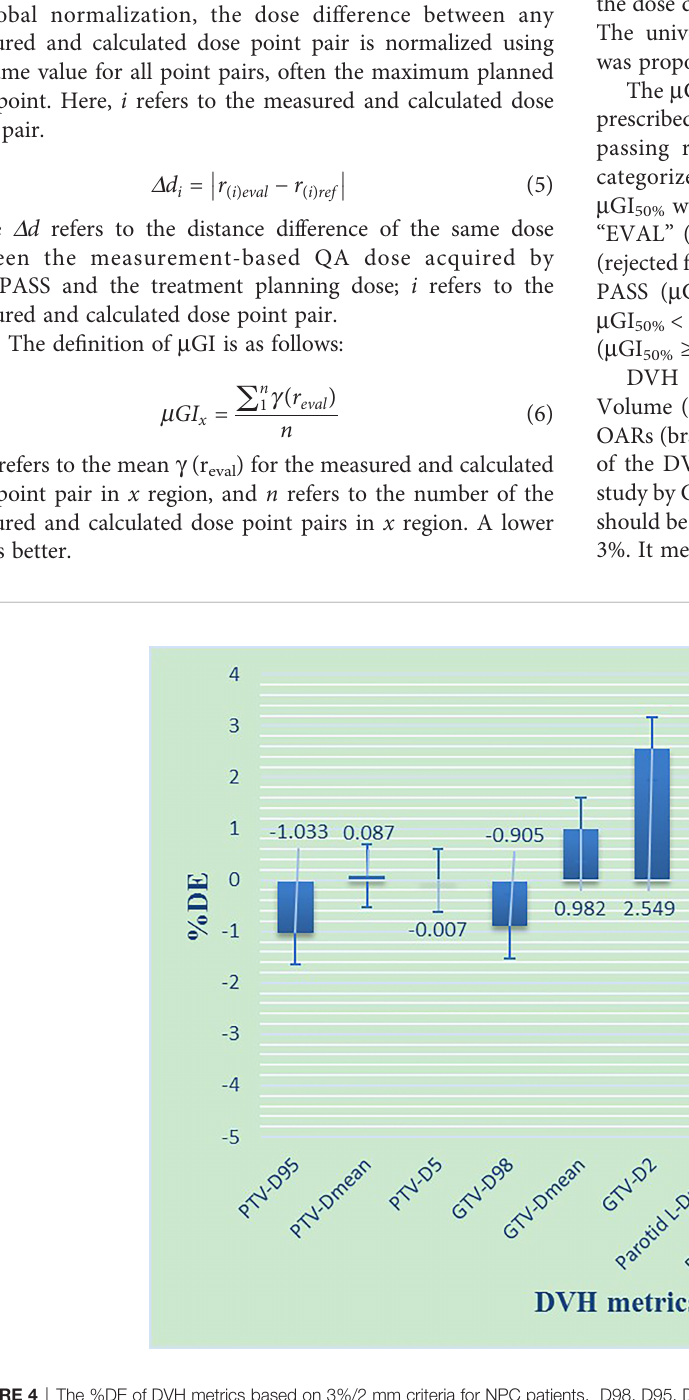
FIGURE 4 | The %DE of DVH metrics based on 3%/2 mm criteria for NPC patients. D98, D95, D5, and D1 refers to the dose received by 98%, 95%, 5% and 1% volume of the structures including PTV, GTV, Parotid gland, Brainstem, Spinalcord, respectively. Dmean refers to the mean dose of the